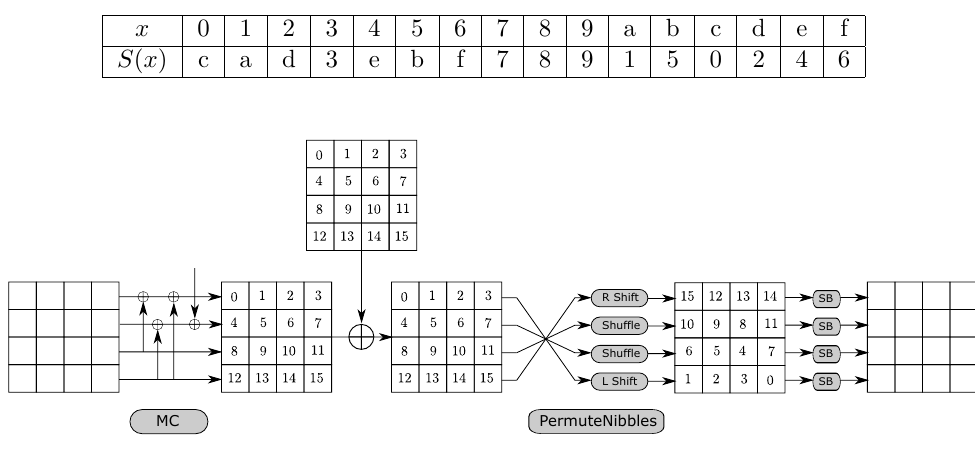
Table 9: The S-box used in CRAFT